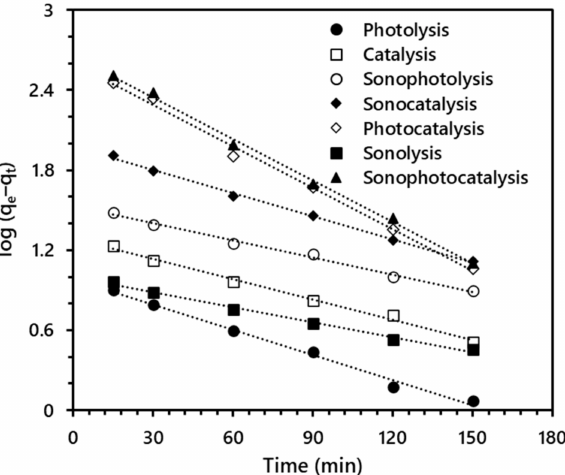
Figure 10. Pseudo-first-order kinetic plot for COD removal from TPOME via different advanced oxidation